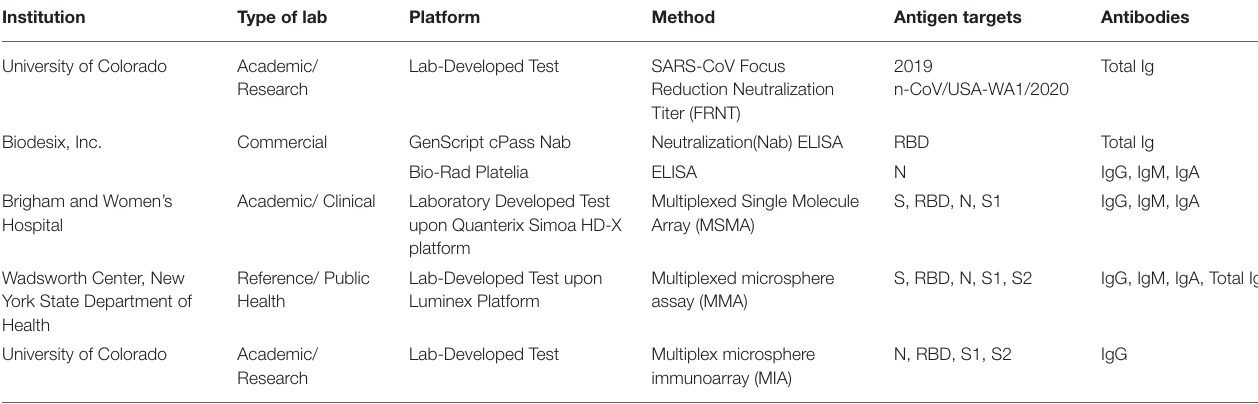
TABLE 2 | SARS-CoV-2 serology harmonization testing laboratories and methods. Institution